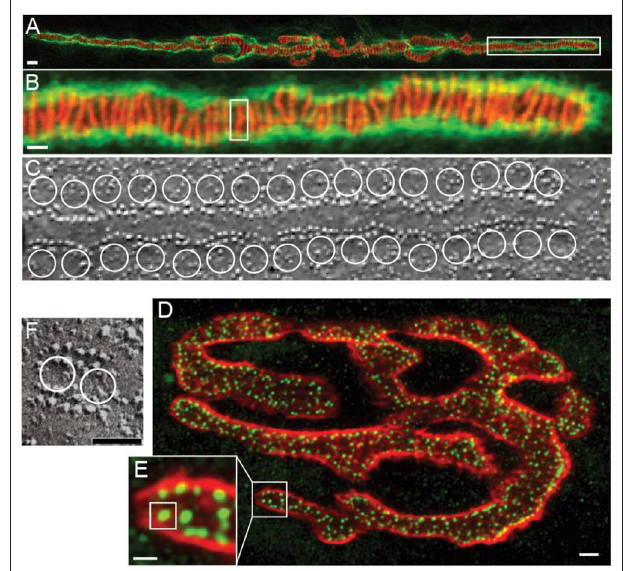
FIGURE 1 | Active zones at frog and mouse NMJs. (A) Confocal image of a single frog NMJ stained with Alexa 594 a-bungarotoxin (red) and peanut agglutinin (green). The a-bungarotoxin staining predicts the location of AZs because this toxin binds to the rows of acetylcholine receptors that are immediately adjacent to the presynaptic active zones. (B) Enlargement of the portion of the image in A that is contained in the white box to show the parallel arrangement of long linear AZs. A single AZ is shown in the white box. (C) Freeze-fracture electron micrograph of a single AZ showing the characteristic two double rows of intramembranous particles that are thought to represent AZ proteins. White circles are drawn to represent the predicted position of docked synaptic vesicles. (D) Confocal image of a single mouse NMJ stained with Alexa 594 a-bungarotoxin (red) and an antibody to the protein bassoon (green). The bassoon staining identifies the location of AZs. (E) Enlargement of the portion of the image in (A) that is contained in the white box to show the small punctate AZs. A single AZ is shown in the white box. (F) Freeze-fracture electron micrograph of a single AZ showing the characteristic two double rows of intramembranous particles that are thought to represent AZ proteins. White circles are drawn to represent the predicted position of two docked synaptic vesicles. Adapted from Heuser et al. (1979), Fukuoka et al. (1987), and Laghaei et al.